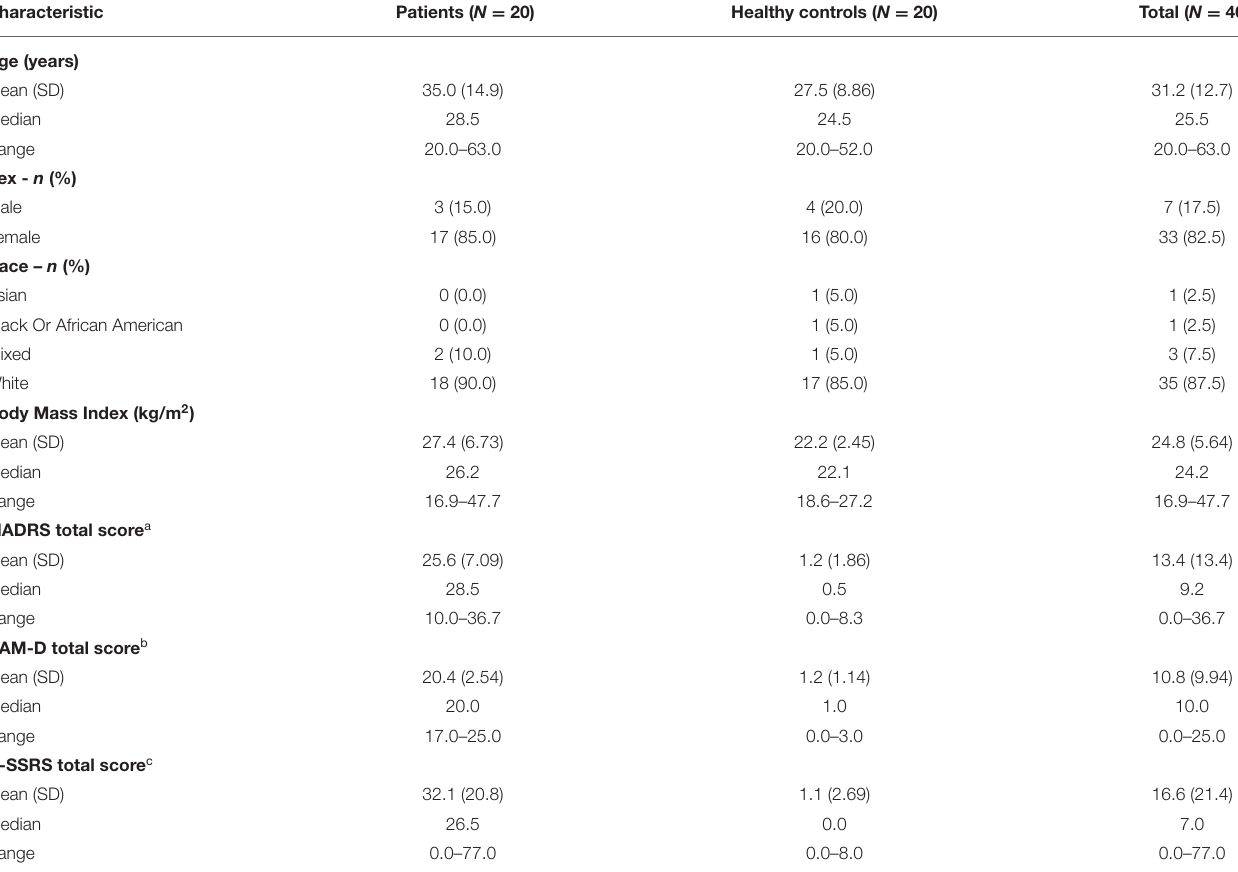
TABLE 1 | Demographic and baseline characteristic summary.